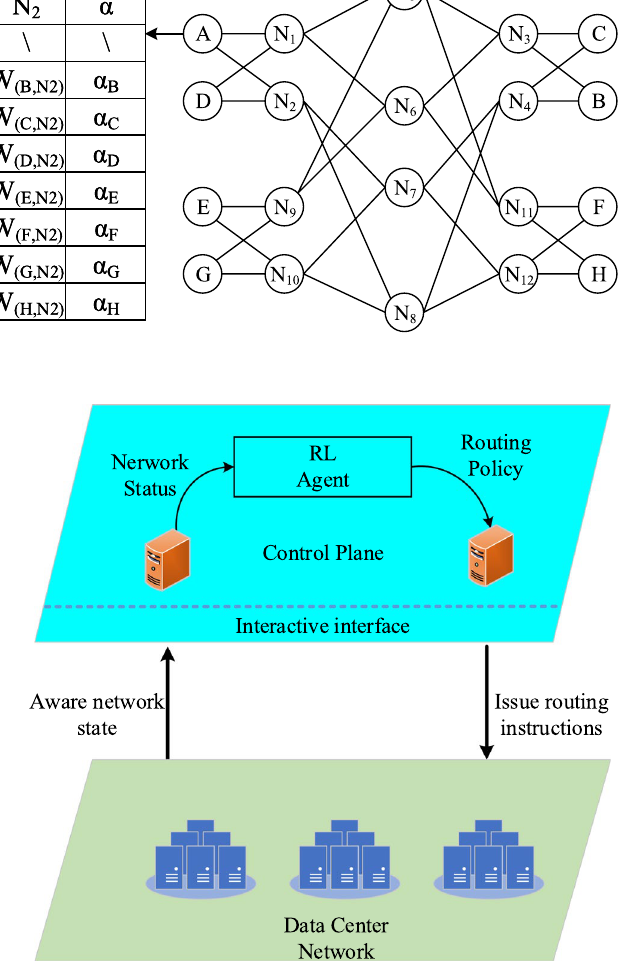
Fig. 4 Route control mechanism based on time segment